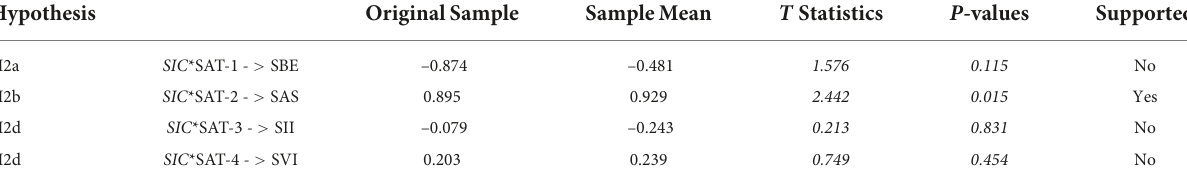
TABLE 9 Moderation